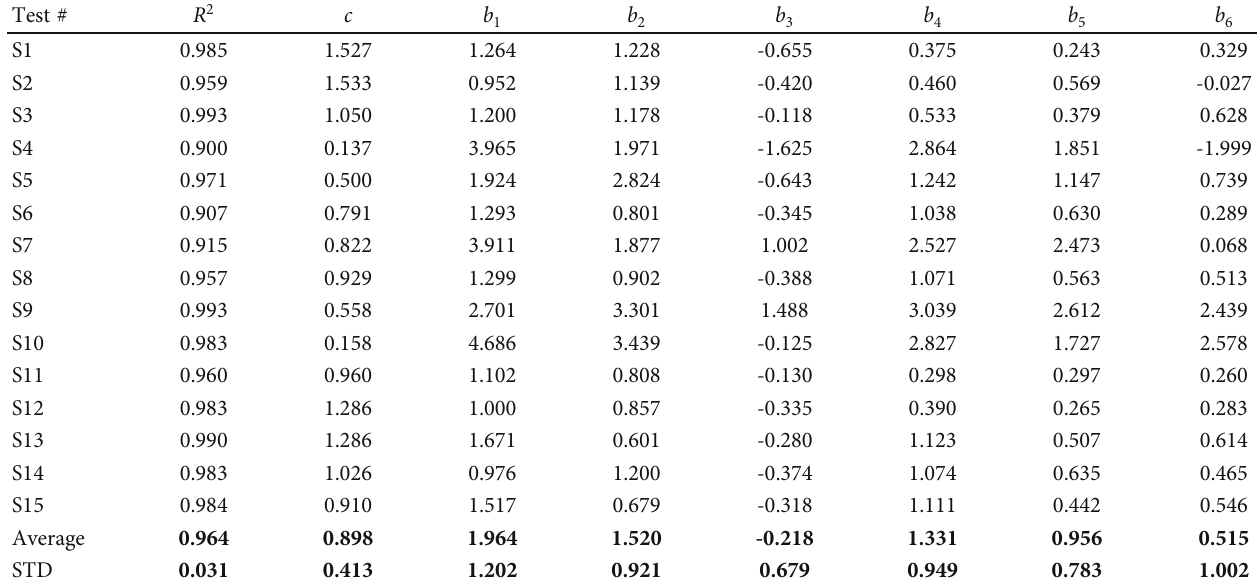
Table 2: Estimated material parameters of porcine sclera soft tissue loaded biaxially using Fung hyperelastic constitutive model including the coe ffi cient of determination ( R 2 ) of each specimen ( N = 15 ). The average constitutive ( c , b 1 , b 2 , b 3 , b 4 , b 5 , b 6 , and R 2 ) parameters are also included.